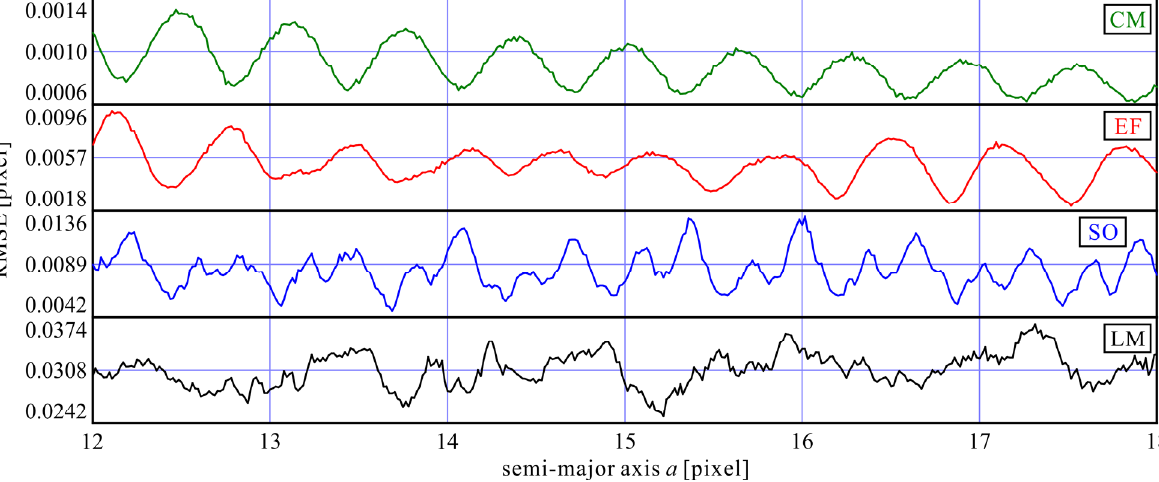
Rotation angle  = 45º : Figure 9 and Figure 10 show the RMSEs of the center location measurement of an ellipse with the flattening f = 0.25 and f = 0.50 when  = 45.0º respectively. The semi-major axis a of an ellipse was examined at 1/64 (= 0.015625) pixel intervals from 12 to 18 pixels. The vertical axes of Figure 9 and Figure 10 are expressed on a linear scale.